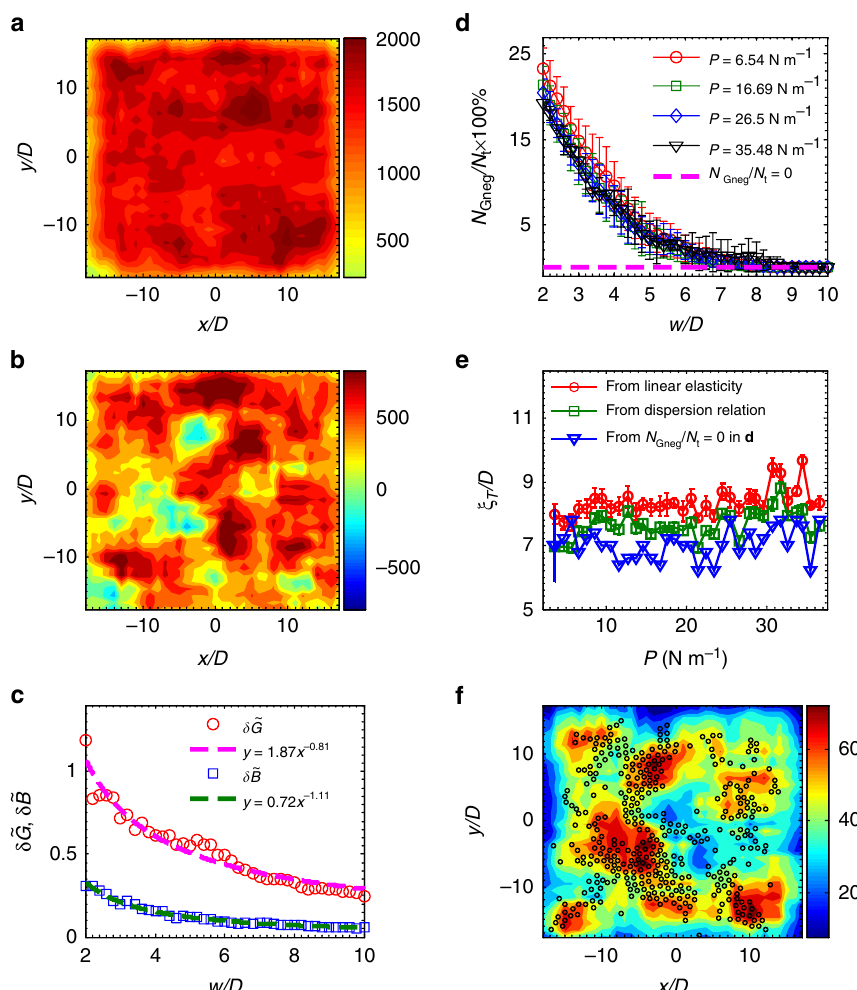
Fig. 6 Heterogeneity of local moduli. Contour plot of the local bulk B a and shear G moduli b at P = 26.50 N m − 1 . Here, the coarse-graining size w = 5 D , where D is the mean diameter of the particles. Both B and G include af fi ne and nonaf fi ne components, and there are negative values in G but not in B . ( red circles ) and δ ~ B (cid:3) δ B h ( blue squares ) that satisfy the power-law fi tting ( dashed lines ). Here, δ ~ B / w (cid:2) 1 : 11 and c Relative fl uctuations of moduli δ ~ G (cid:3) δ G h G i B i δ ~ G / w (cid:2) 0 : 81 . The data points here are ensemble averaged for seven realizations of P = 26.5 N m − 1 ,other pressures show the similar results, and the error bars are within the symbol size. d The percentage of the negative G vs. w at P = 6.54 ( red circles ), 16.69 ( green squares ), 26.5 ( blue diamonds ), and 35.48 ( black inverted triangles ) N m − 1 . The characteristic length can be determined from the crossover between each curve and the zero line (i.e., the magenta ffiffiffiffiffiffiffiffi p dashed line ). e Comparison of three characteristic lengths: (1) from linear elasticity values of v T ¼ G = ρ and ξ T = 2 π v T / ω b ( red circles ), (2) from the dispersion relation ( green squares ), and (3) from the above crossover ( blue inverted triangles ). The error bars in d – e signify one SD around the mean value obtained from ∼ 10 realizations of each pressure. f The spatial correlation between the nonaf fi ne G (backgrounds) and the superposition of low frequency modes for ω < ω b ( black circles ). Here, w = 7